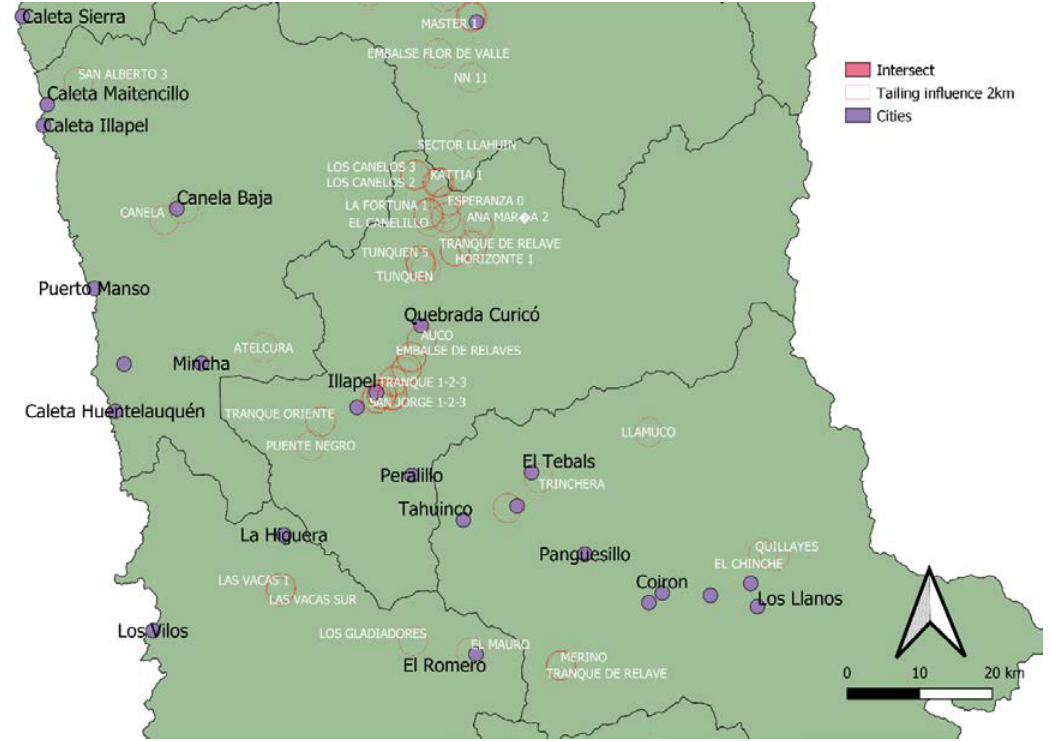
Figure 4. Map of the urban area intersections with tailings distribution in the Coquimbo region.